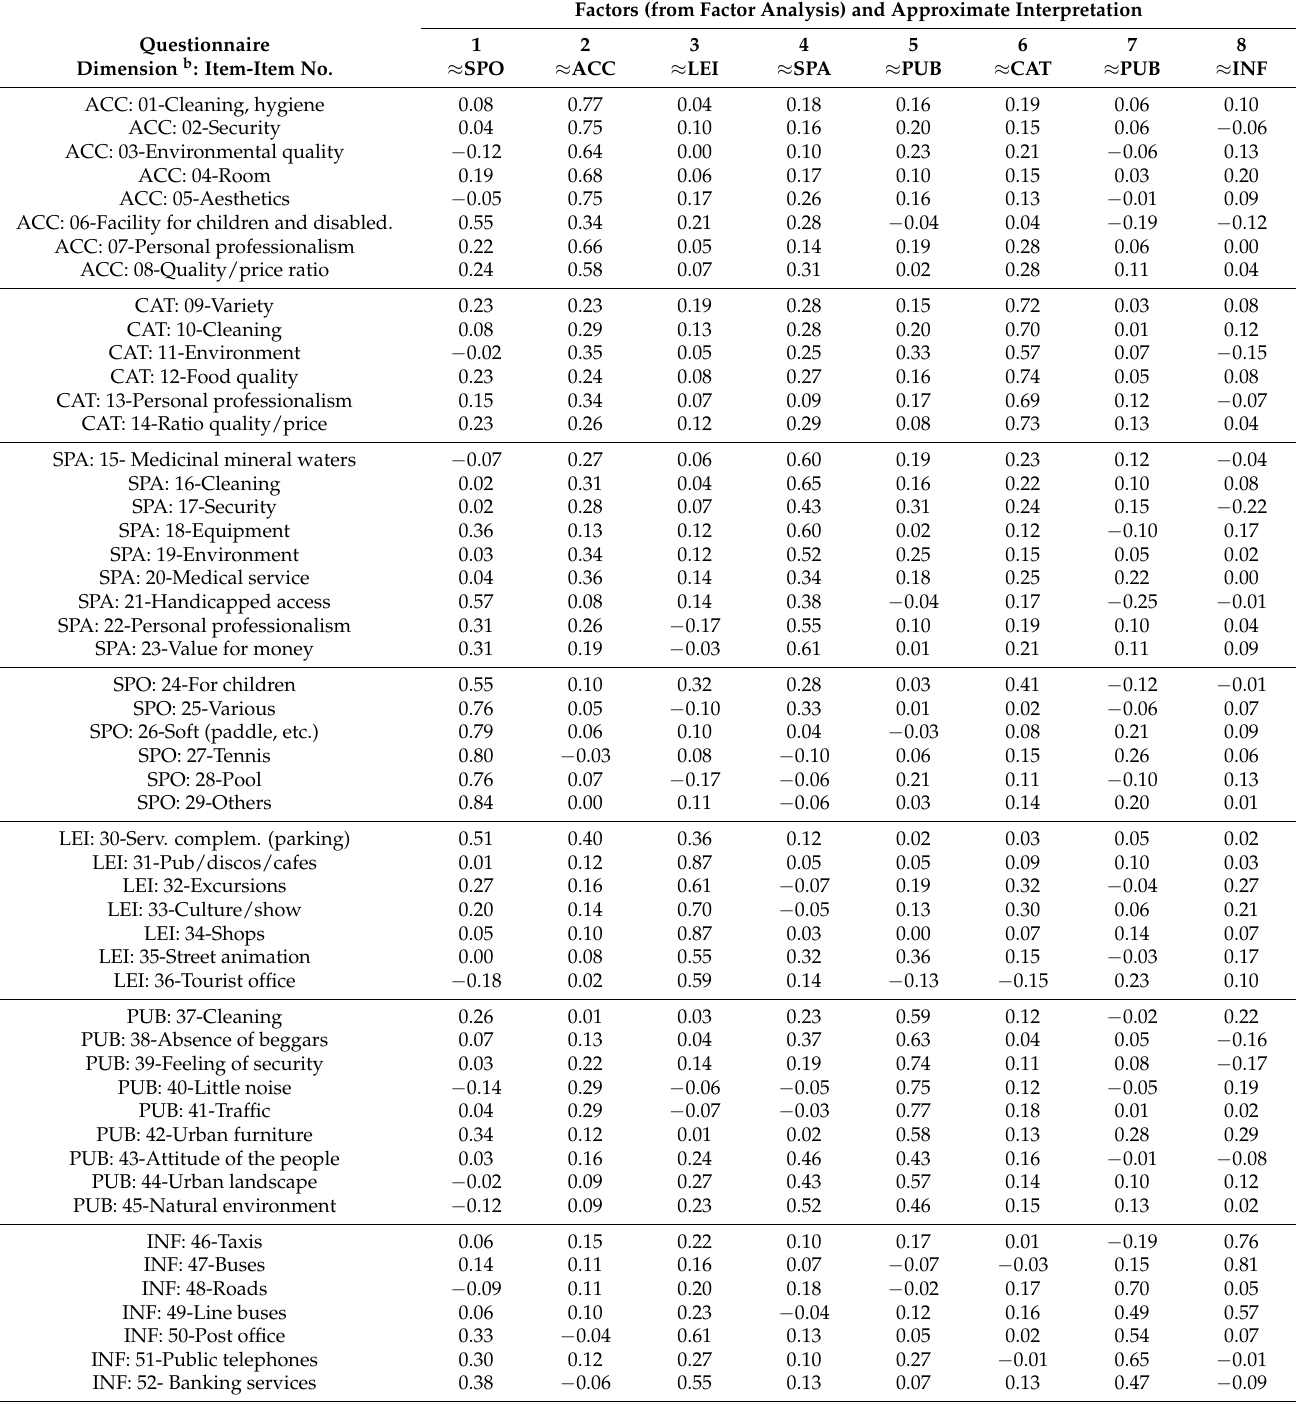
Table 7. Factor analysis ( n = 725). Factors (8) after Varimax rotation, with all weights a . Factors (from Factor Analysis) and Approximate